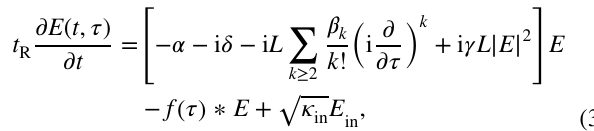
E E R 1 and R 2 are the electric fields at different position in the resonator, where ̃ f ( 𝜔 ) ̃ f ( 𝜔 ) ̃ f ( 𝜔 )] (solid blue line) and phase response arg[ (solid red line) of , where Δ f is usually a multiple | | | | | |